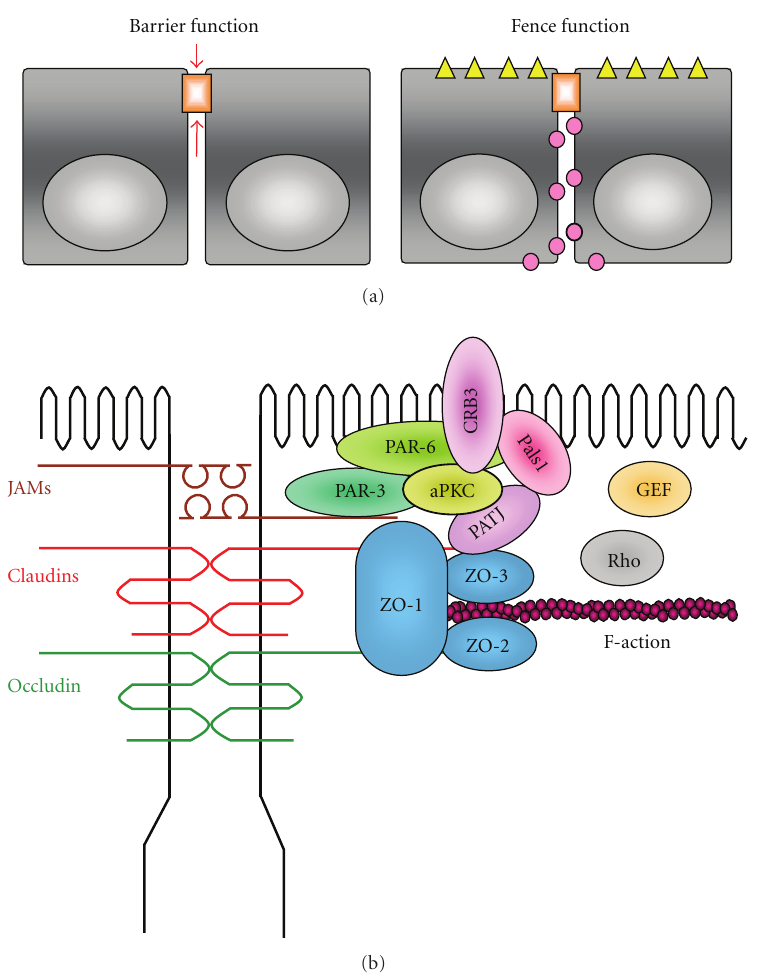
Figure 1: Functions of tight junctions and molecular components. (a) Functions of tight junctions. Barrier function: tight junctions limit the penetration of intercellular material and impose selective permeability. Fence function: tight junctions restrict the di ff usion of proteins and lipids in a cell membrane. (b) Schematic drawing of bicellular junction proteins. Transmembrane and sca ff old proteins of tight junctions and polarity proteins are presented. These drawings are modified from a previously published review